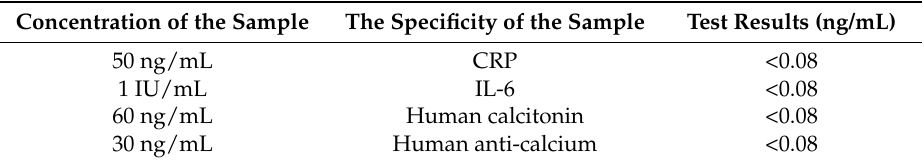
Table 3. Precision results of the CM-EU test strips.